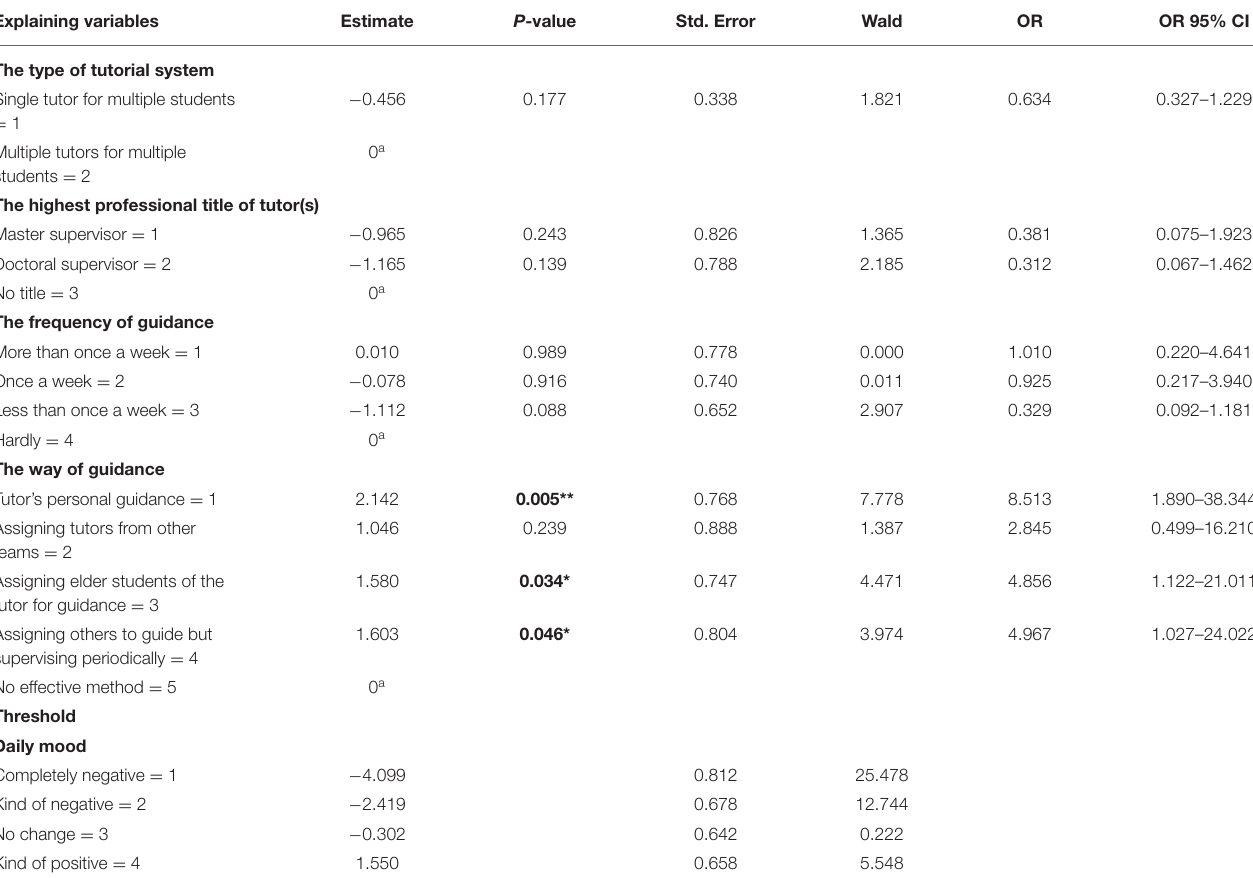
TABLE 4 | Multiple ordinal logistic regression analysis of influential factors of daily mood after the guidance of the tutor. Explaining